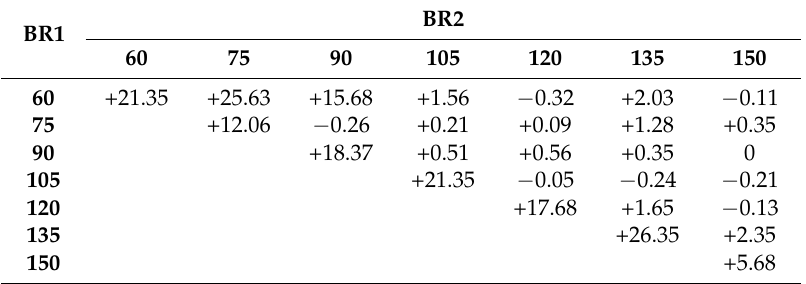
Table 8. Comparison between [6] and the Feature fusion F 1 of this algorithm—FAAC (%).